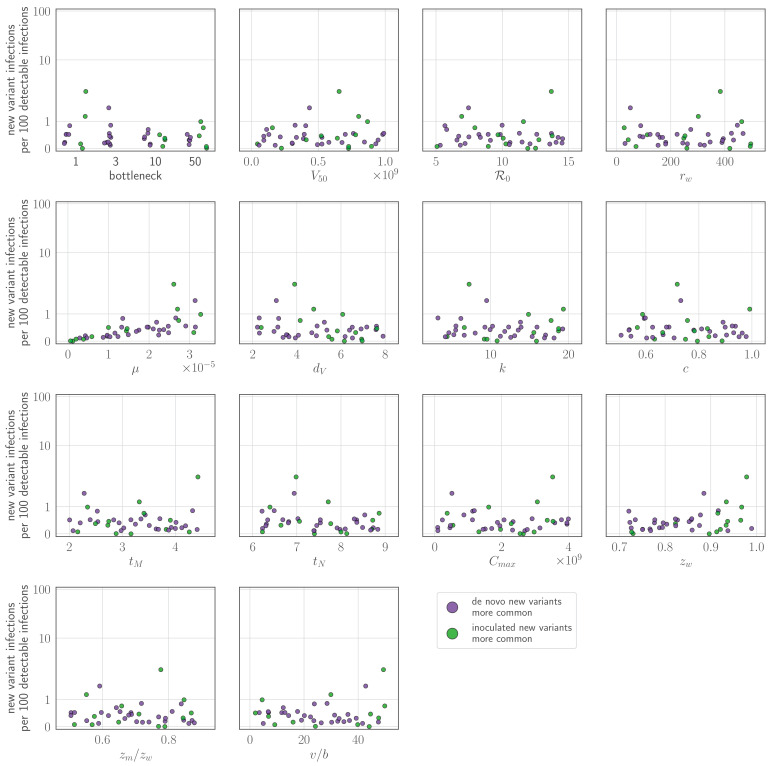
Sensitivity analysis: parameter values versus rate of new variant infections per 100 detectable infections of an experienced host given a realistic (48 hours or more post-infection) recall response.Parameters randomly varied across the ranges given in Table 2, with tM varied between 2 and 4.5. Each point represents a parameter set; the rate of new variant infections per hundred 100 detectable infections is estimated from 50,000 simulated inoculations of an experienced host. A new variant infection is defined as one in which the new variant reached a transmissible frequency of at least 1% at any point in the infection. Points are colored according to whether new variant infections were more frequently caused by de novo generated (purple) or inoculated (green) new variant viruses.